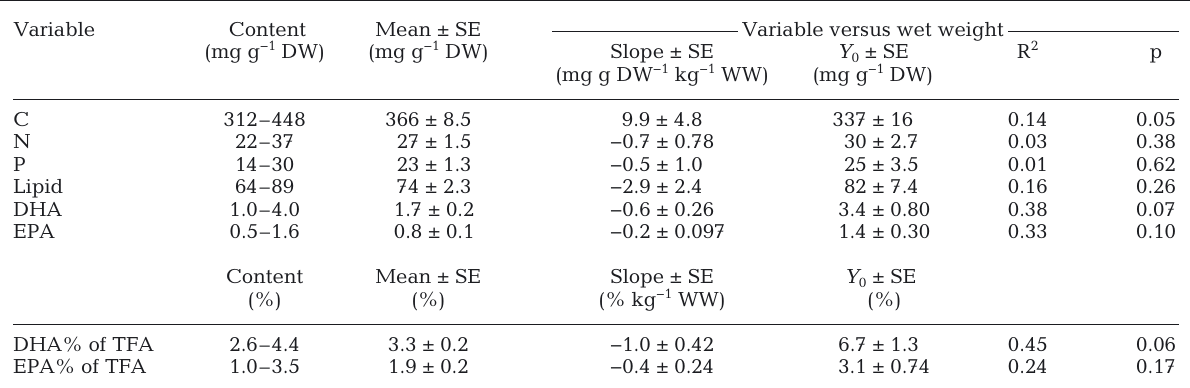
Table 4. Range of chemical content and mean chemical content in faeces samples from March to November 2009 (see Fig. 9 for the monthly chemical content for each cage), as well as regression coefficients for chemical content in faeces samples as a function of fish wet weight (WW; kg). DW: dry weight; DHA: docosahexaenoic acid; EPA: eicosapentaenoic acid; TFA: total fatty